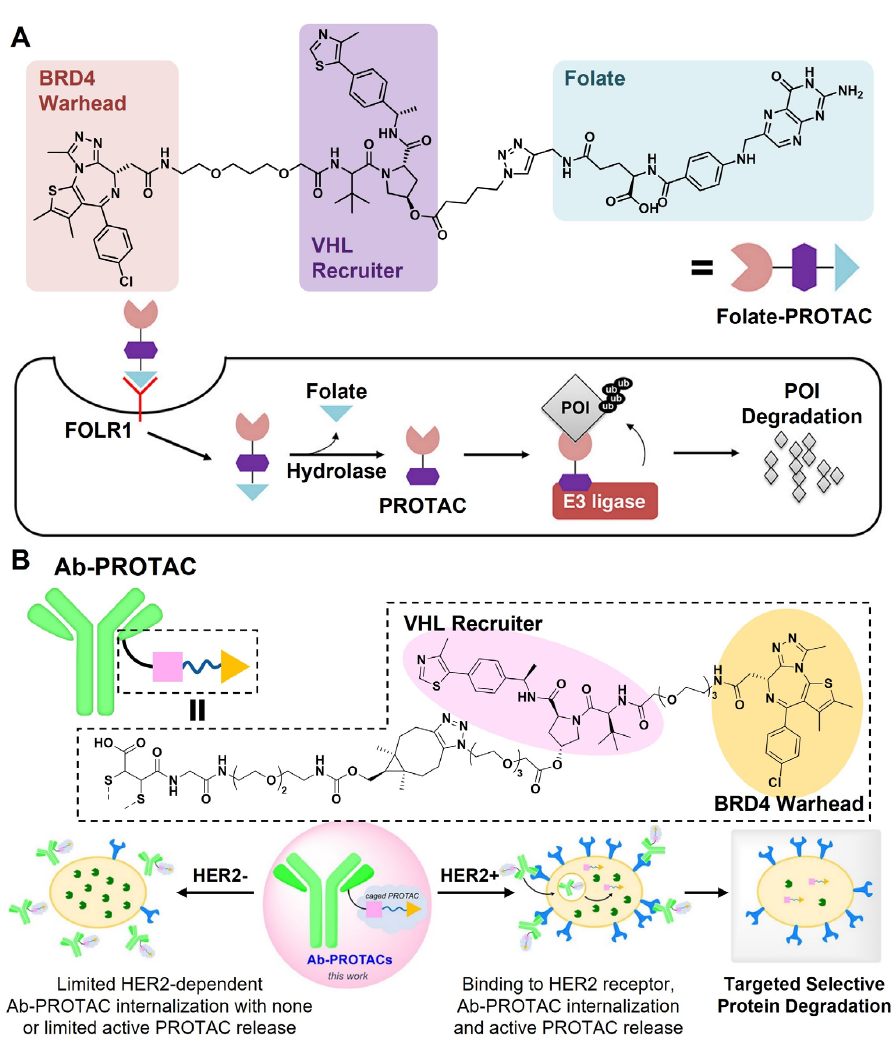
Figure 4. Active targeting moieties for PROTAC delivery. ( A ) The conjugation of folate molecules to PROTACs enhanced the cellular internalization of PROTACs via folate receptor-related pathways. The folate groups were supposed to be hydrolyzed to release free PROTACs in intracellular conditions. Reproduced with permission from [88]. Copyright 2021, American Chemical Society. ( B ) Trastuzumab was exploited for PROTAC delivery, promoting the selective accumulation of PROTACs in HER2-positive cancer cells. Reproduced with permission from [101]. Copyright 2021, American Chemical Society.